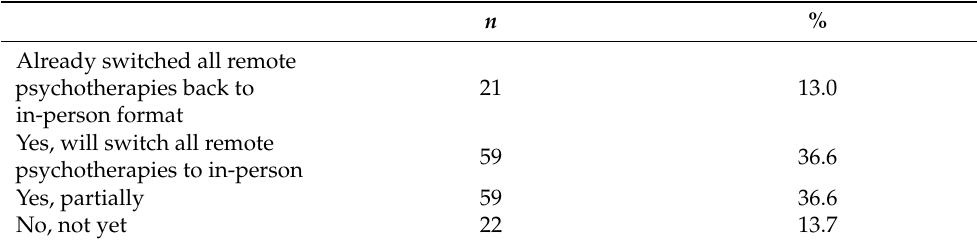
Table 5. Psychotherapists’ intention to change to in-person psychotherapy after the end of the COVID-19